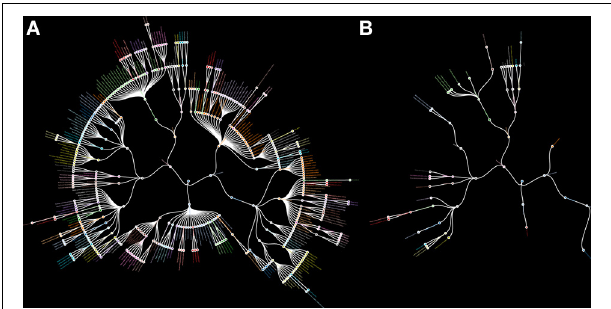
FIGURE 1 | Radial hierarchical tree of the human subcortex. (A) A radial hierarchical tree illustrating the 455 subcortical structures as defined by the Federative Community on Anatomical Terminology (FCAT). The outer edges of the hierarchical tree display the individual subcortical gray matter nuclei. (B) A radial hierarchical tree illustrating seven percent of all subcortical structures as defined by the FCAT that are implemented as standard atlas maps in the three major MRI analysis software packages: FSL, SPM, and